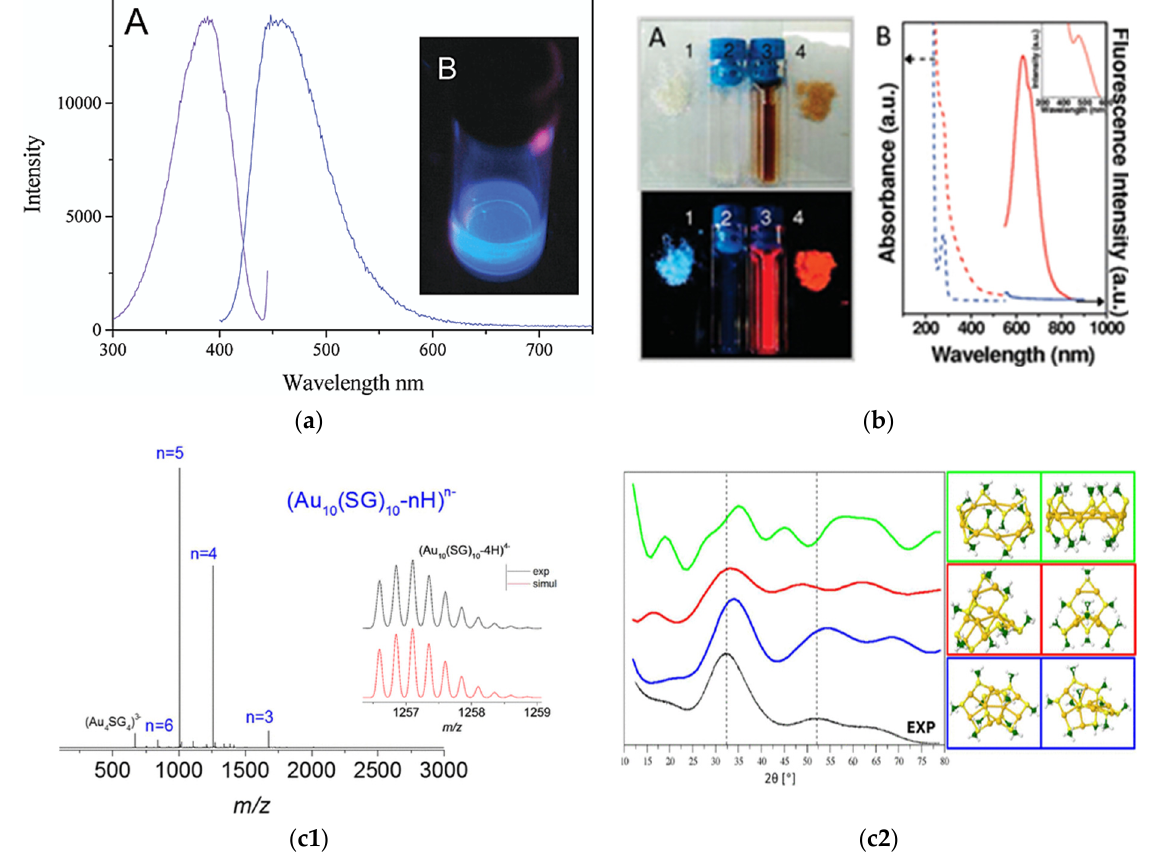
Figure 1. ( a ) : Excitation and emission spectra of Au 8 nanodots. Inset shows digital photograph of Au 8 nanodots, upon excitation at 366 nm. Reprinted with permission from [26] . Copyright 2003 American Chemical Society. ( b ) (A) Digital photographs of BSA stabilized Au NCs and control BSA (solution and powder) under visible and UV light. (B) Absorption and emission spectra of BSA stabilized Au NCs and control BSA. Reprinted with permission from [28]. Copyright 2009 American Chemical Society. ( c1 ) Electrospray ionization (ESI) mass spectrum of Au 10 clusters stabilized by glutathione. ( c2 ) Experimental and simulated X-ray diffraction patterns of various isomers of Au 10 clusters stabilized by glutathione. Reprinted with permission from [35] . Copyright 2017 American Chemical Society.